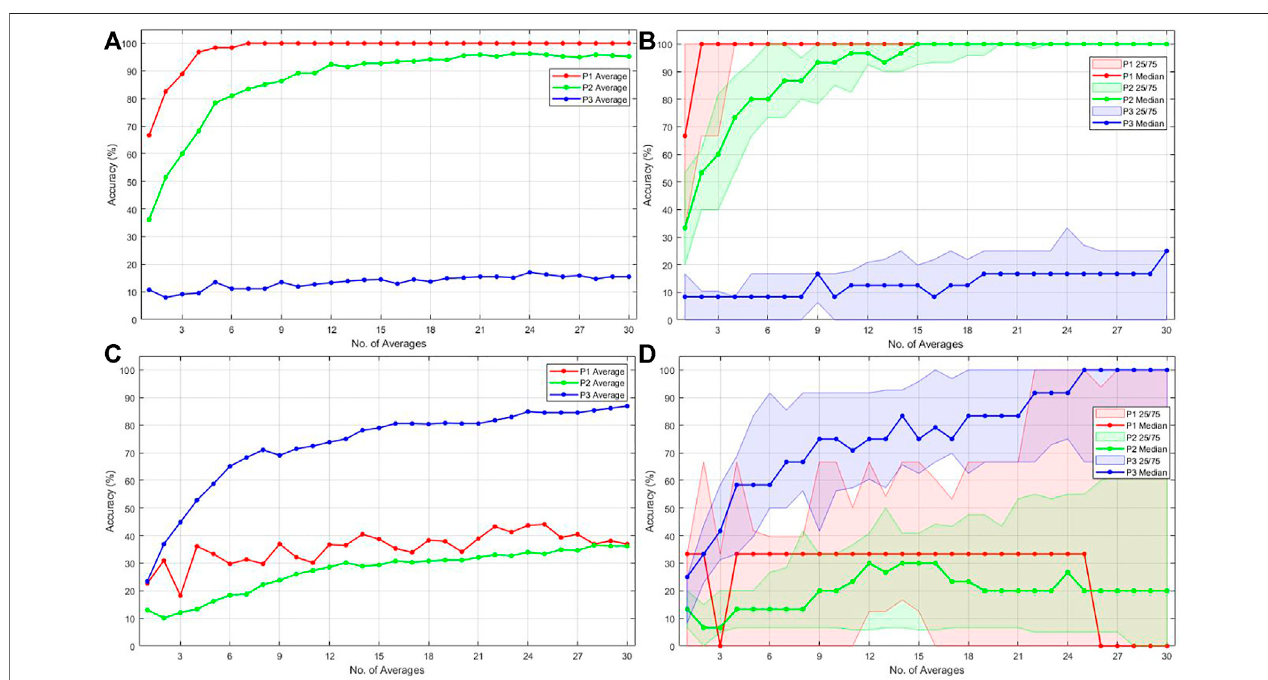
FIGURE6| Accuracyresults for 1to30test trials and paradigmsP1,P2, and P3for21subjects. Measurementsetup part one (A) , (C) (Training paradigm P1) and part two (B) , (D) (Training paradigm P4). On the left side (A) and (B) depict the average accuracy. On the right side (C) and (D) depict the median accuracy with the shaded area representing the 25th (Q1) and 75th (Q3) percentiles.